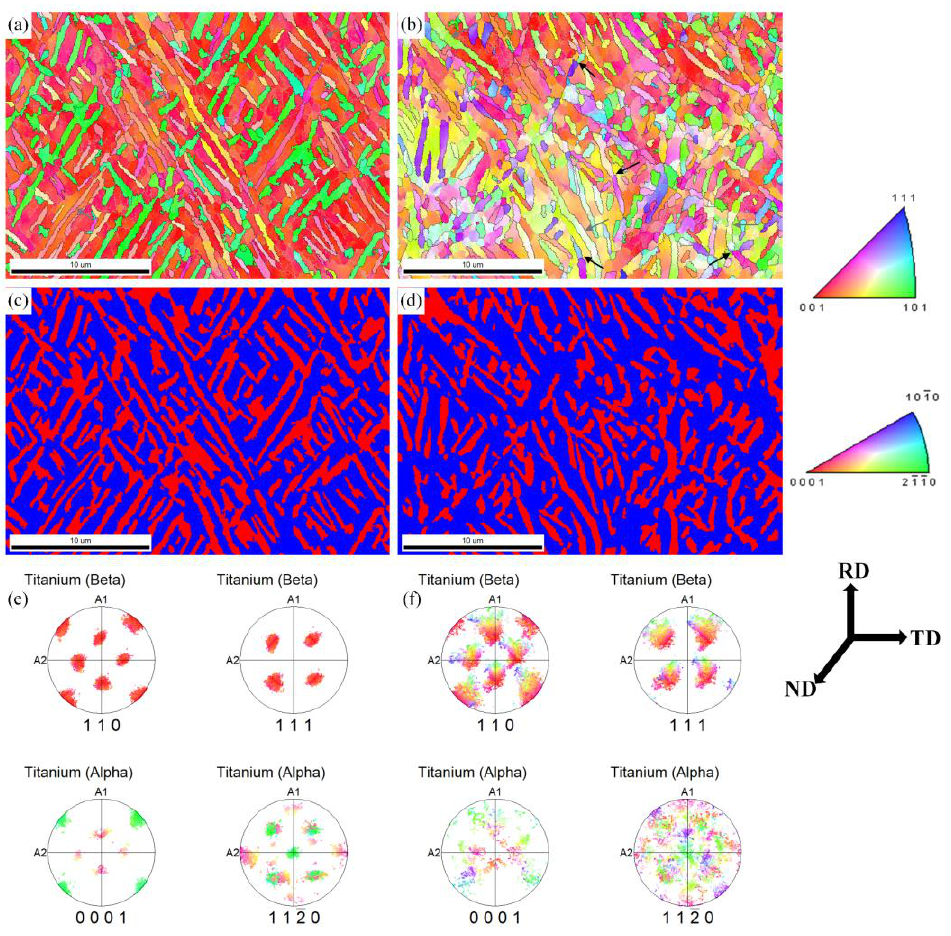
Figure 5. IPF color maps and phase maps of α and β phases with a strain of ( a , c ) 0.32, ( b , d ) 0.83; pole figure of α and β phase with a strain of ( e ) 0.32, ( f ) 0.83.